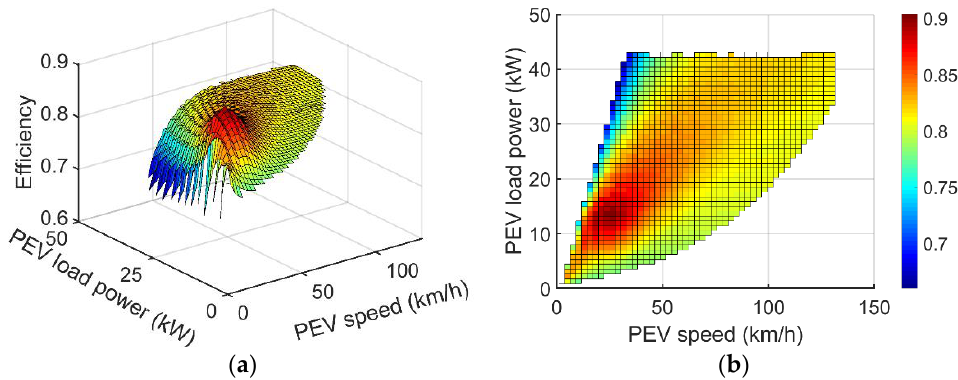
Figure 7. Vehicle characteristics of working mode 1 under original parameters. ( a ) MAP of efficiency characteristic; ( b ) working area and corresponding efficiency.